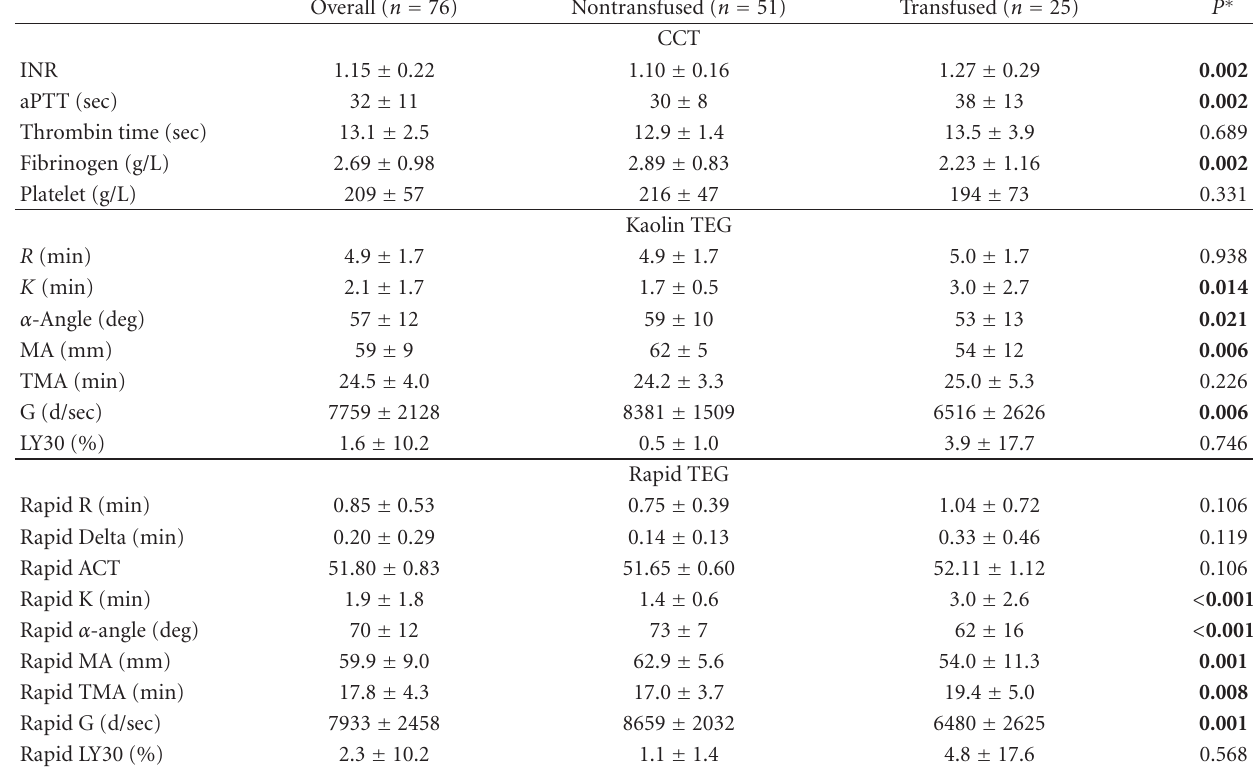
Table 3: Conventional coagulation test results, Kaolin TEG and Rapid TEG measurements in overall group, nontransfused and transfused patients.